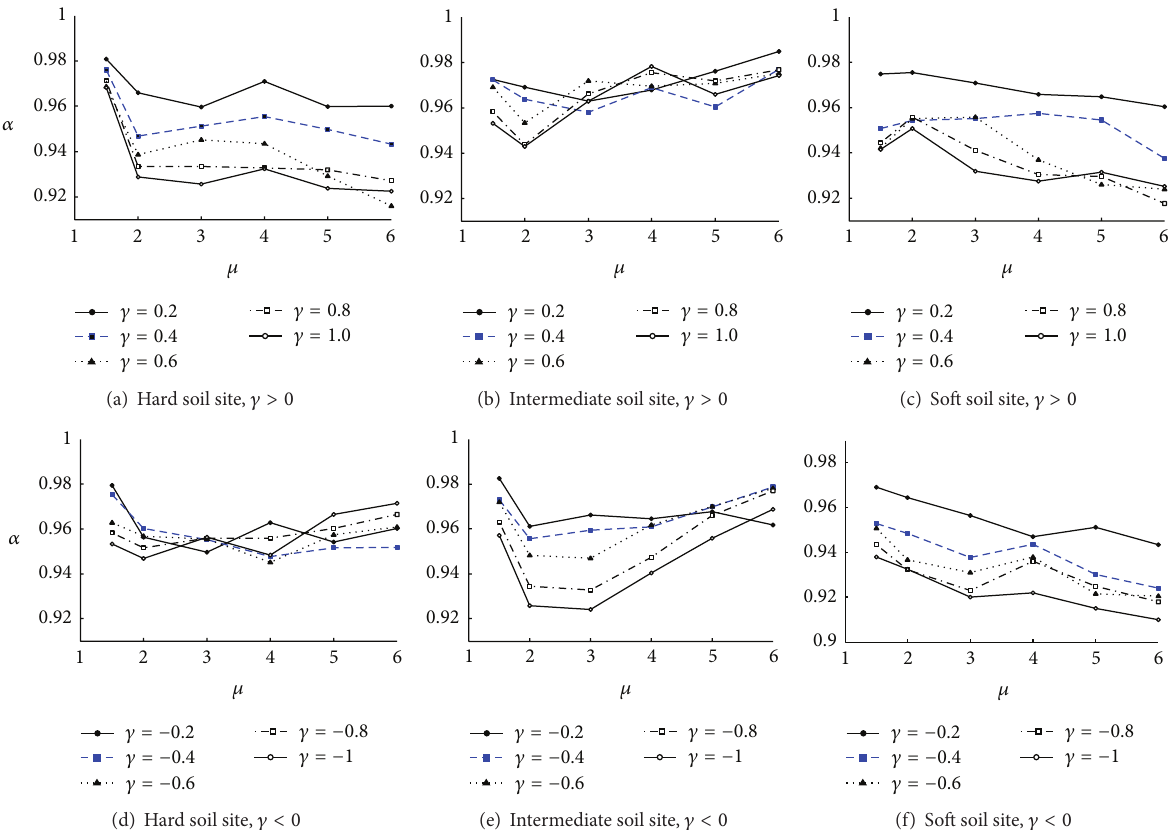
Figure 3: Analysis of modification coefficient 𝛼